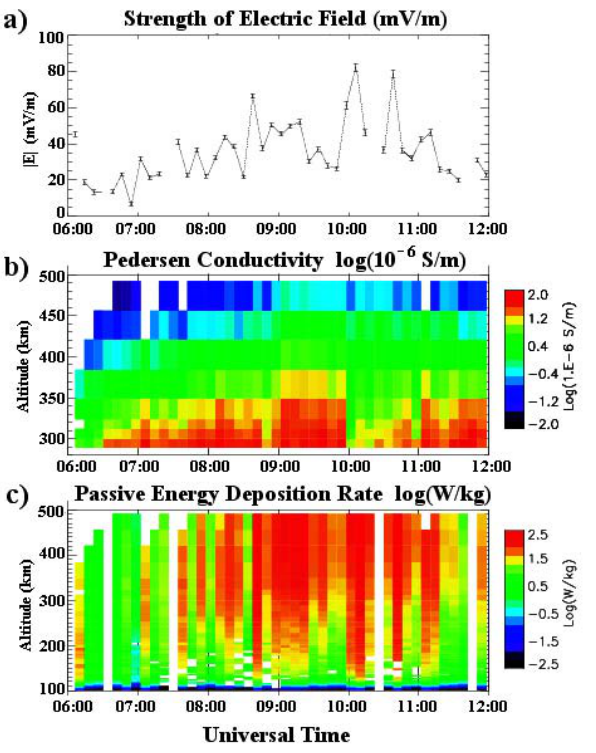
Fig. 6. (a) The strength of the electric field, | E | , (b) the Pedersen conductivity above 290km, and (c) the passive energy deposition rate per unit mass, σ P E 2 / ρ , obtained from the ESR observations during 06:00–12:00 UT. E is the electric field, σ P is the Pedersen conductivity, and ρ is the neutral mass density obtained from the MSISE-90 empirical model.